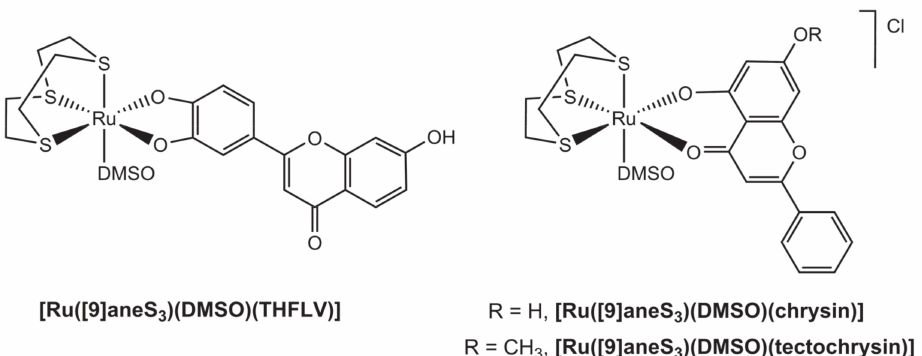
Figure 7. Structural representation of the neutral complex [Ru([9]aneS 3 )(DMSO)(THFLV)], with [9]aneS 3 = trithiacyclononane and THFLV = ( bis -deprotonated) 7,3 (cid:48) ,4 (cid:48) -trihydroxyflavone (left) and the cationic complexes [Ru([9]aneS 3 )(DMSO)(chrysin)]Cl and [Ru([9]aneS 3 )(DMSO)(tectochrysin)]- Cl